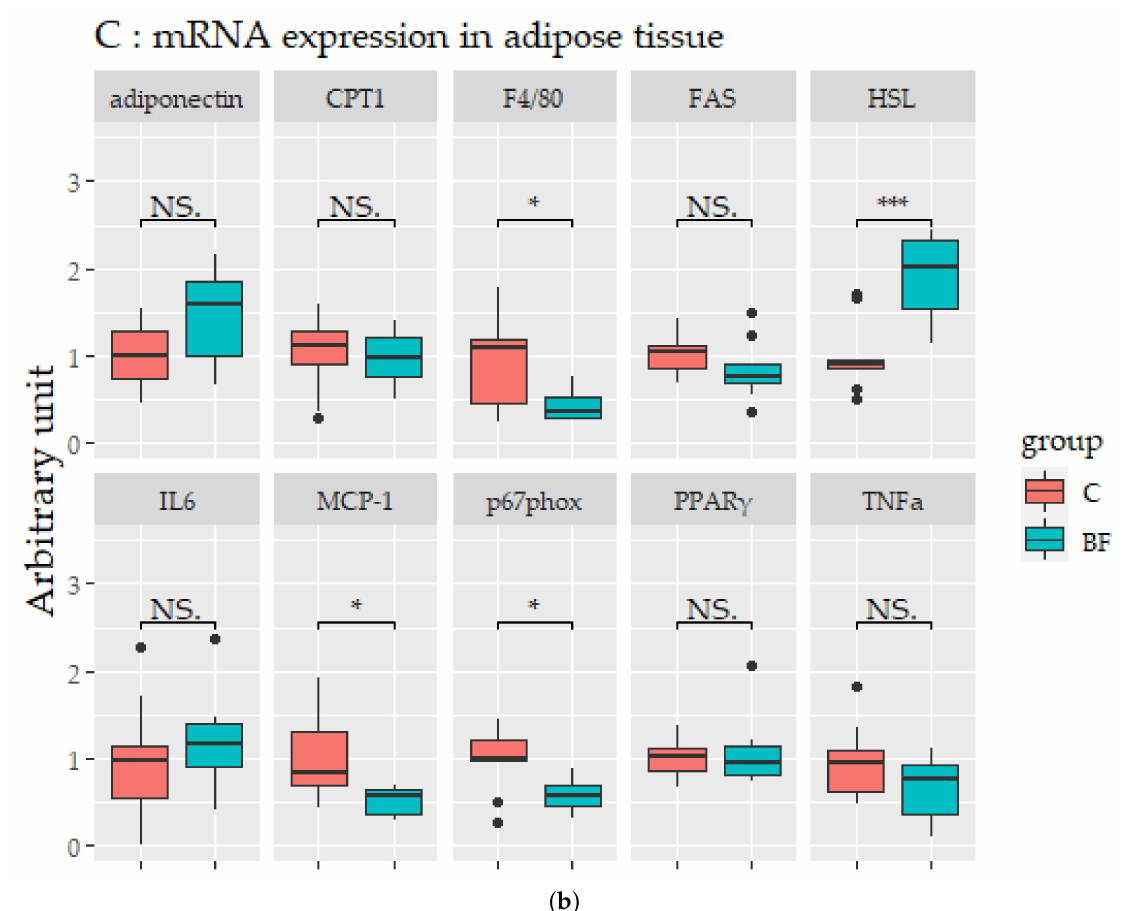
Figure 6. The expression levels of mRNA in the ileum ( A ), liver ( B ), and adipose ( C ) tissues. Values are means ± SD. * p < 0.05, ** p < 0.01, *** p < 0.001 significantly di ff erent from the control group. NS.: not